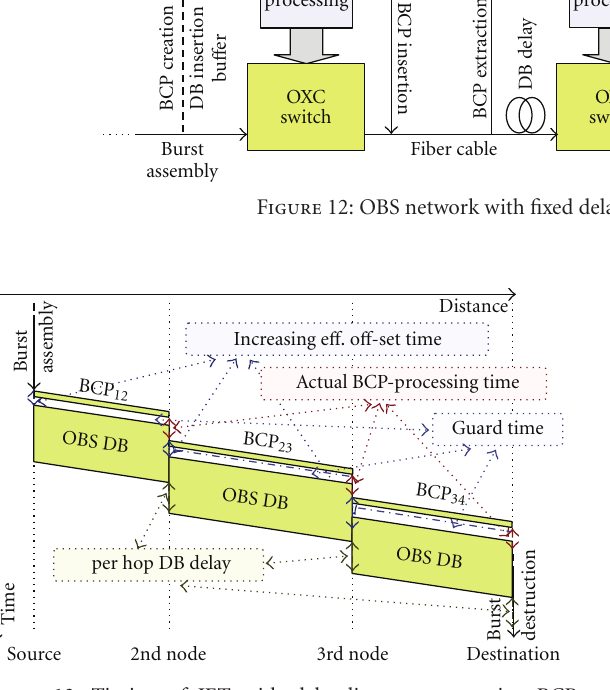
Figure 13: Timing of JET with delay-lines compensating BCP